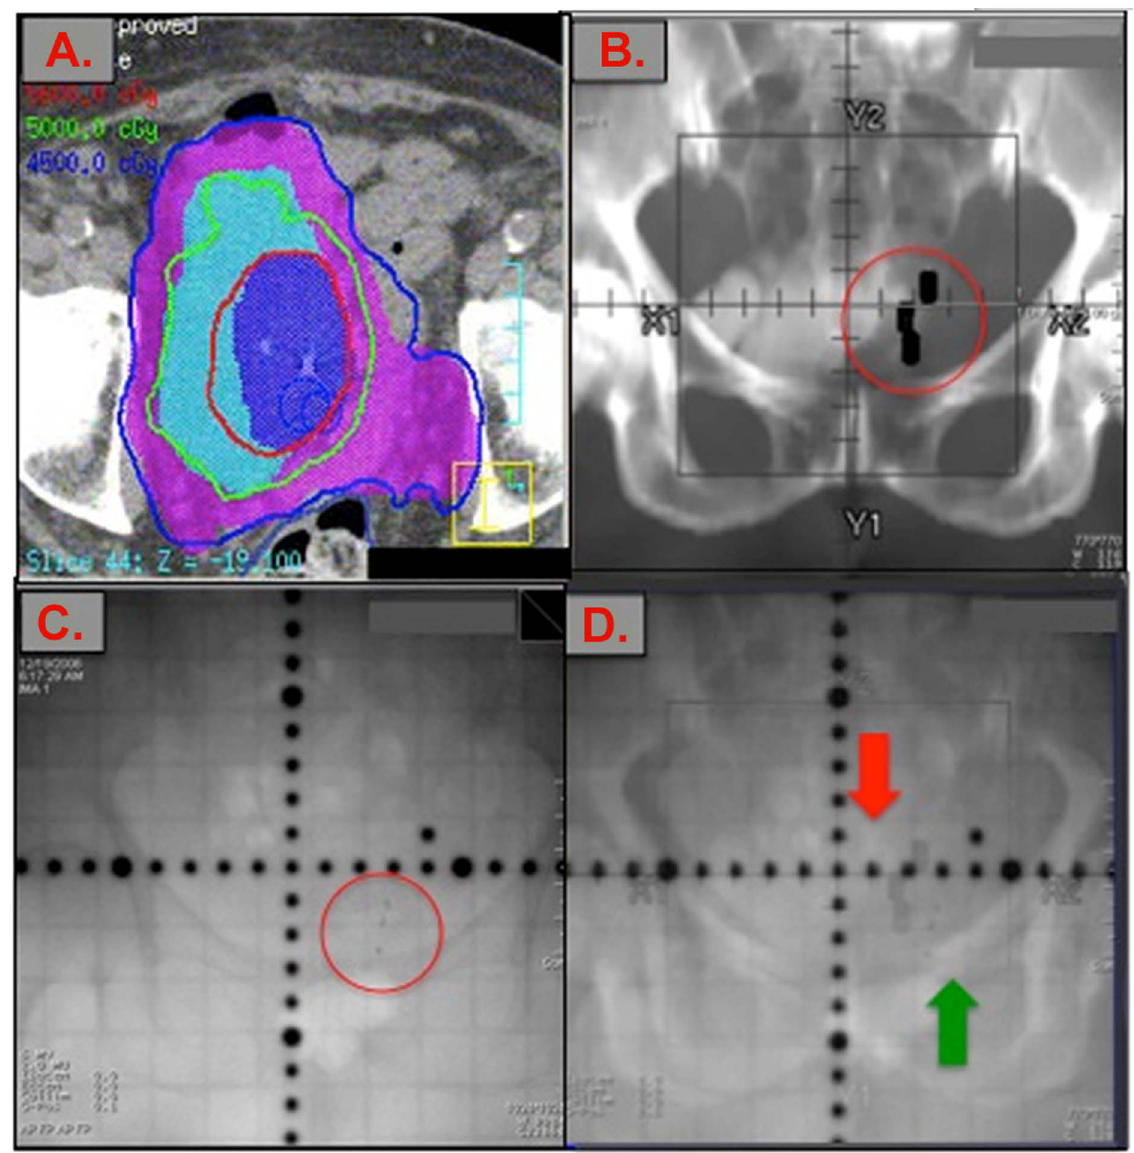
Figure 7. Computed Tomography (CT), Digitally Reconstructed Radiograph (DRR), and on-table Portal images with fiducial markers present. ( A. ) Computed Tomography (CT-scan) dosimetry imaging of pelvis with bladder fiducial markers in place. The gross tumor volume (GTV; dark blue) received 56-Gy in 25 fractions. The clinical tumor volume (CTV; light blue) equals the bladder and received 50 Gy in 25 fractions. The planning tumor volume (PTV; purple) equals the CTV + 1 cm + the ipsilateral pelvic side-wall. ( B. ) Digitally reconstructed radiograph (DRR) of pelvis; shows the anticipated location of the three markers we placed at the tumor site (large black rectangles), based on the gold markers visible on planning CT. ( C. ) Gold markers seen on an AP portal image of pelvis, ( circled ), ( D ) Fusion of the DRR and AP portal images showing the predicted position for gold markers (red arrow) compared to the true position of the gold markers (green arrow) prior to any patient adjustment.